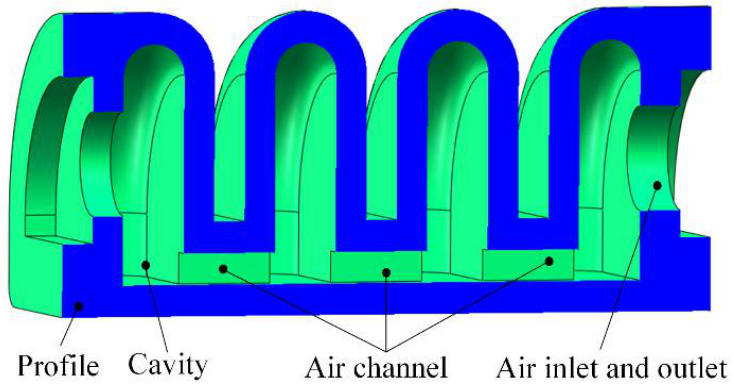
Figure 5. The middle finger joint structure.